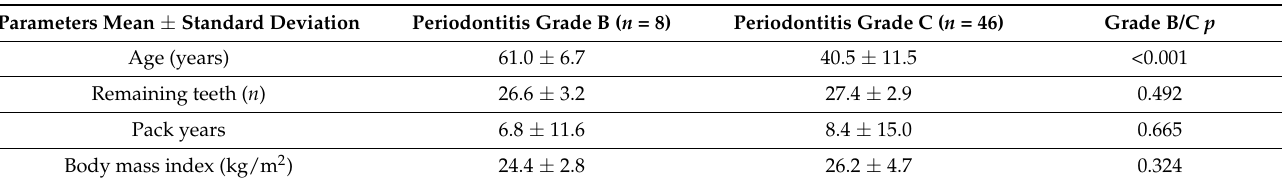
Table 1. Individuals’ characteristics.